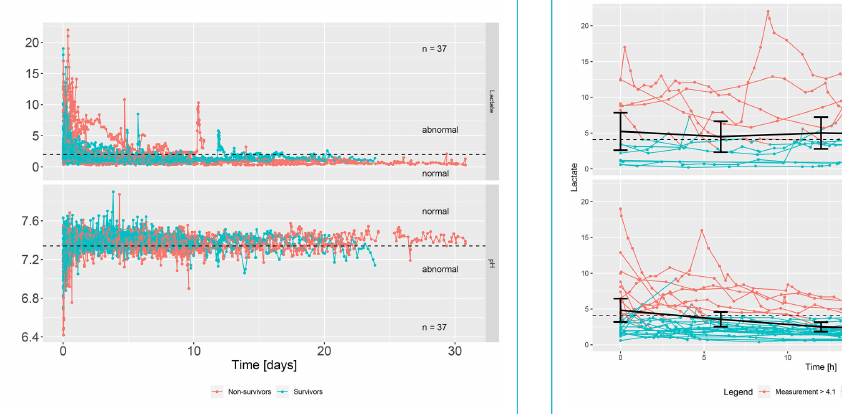
Figure 2: Lactate and pH curves during intensive therapy (sur- vivors / non-survivors). Lactate >2 mmol/l and pH <7.34 were con- sidered abnormal.